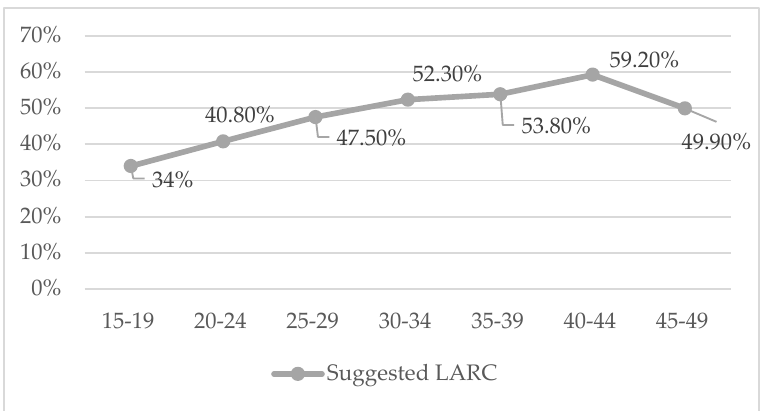
Figure 4. Counselling for the use of LARCs according to age group.